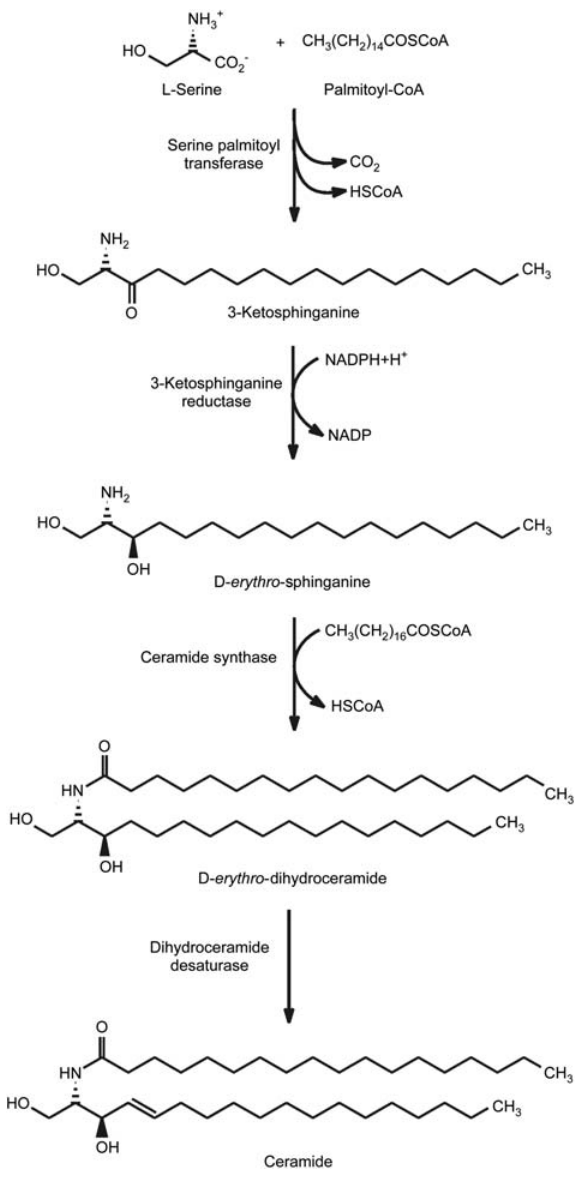
Figure 1 Ceramide de novo synthesis. CerS catalyze the CoA-dependent de novo ceramide synthesis. CoA activated fatty acids with varying chain lengths are used for ami- noacylation of sphinganine carbon-2 to yield dihydroceramide, which is reduced to ceramide by dihydroceramide